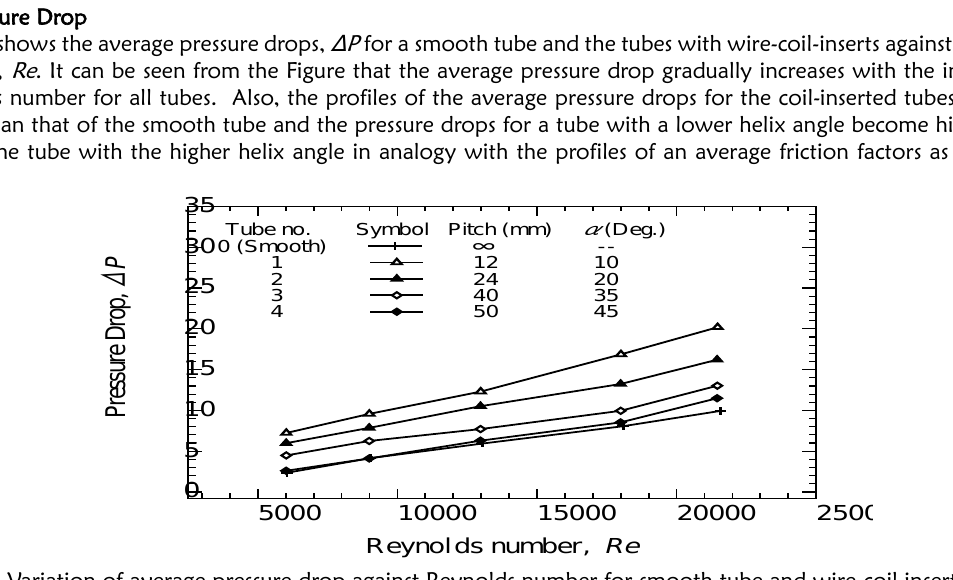
Figure 4: Variation of average pressure drop against Reynolds number for smooth tube and wire-coil inserted